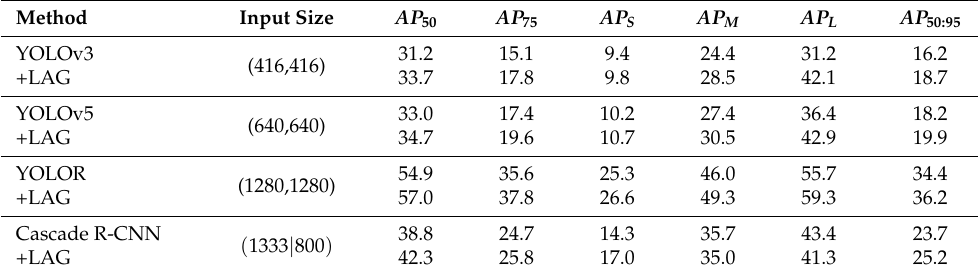
Table 7. The effects of LAG on different detectors under the VisDrone dataset.